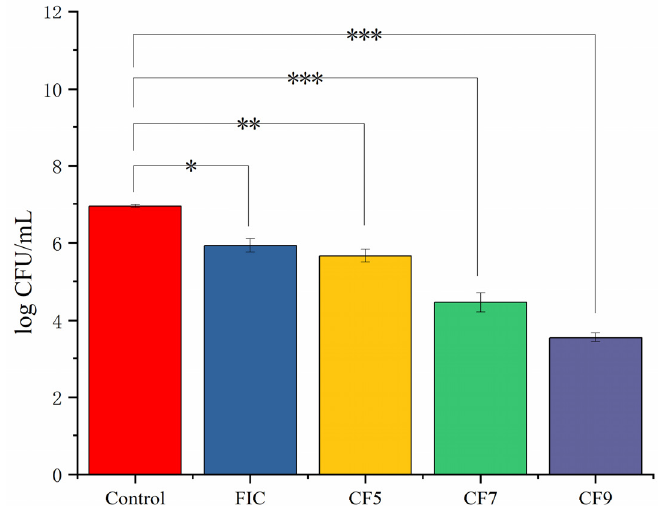
Figure 2. Effects of different treatments on the survival rate of H. pylori 3192 biofilm. Four-day mature H. pylori biofilm was treated with different treatments, and the survival rate was counted on a blood agar plate after 72 h. Control group: BB2, FIC group: 1 × FIC of AMX and CLR, CF5 group: 6.25% CFS of 10 5 CFU/mL L. salivarus LN12 in combination with 1 × FIC of AMX and CLR, CF7 group: 6.25% CFS of 10 7 CFU/mL L. salivarus LN12 in combination with 1 × FIC of AMX and CLR, CF9 group: 6.25% CFS of 10 9 CFU/mL L. salivarus LN12 in combination with 1 × FIC of AMX and CLR. AMX: Amoxicillin, CLR: Clarithromycin. ∗ : p ≤ 0.05, ∗∗ : p ≤ 0.01, and ∗∗∗ : p ≤ 0.001.